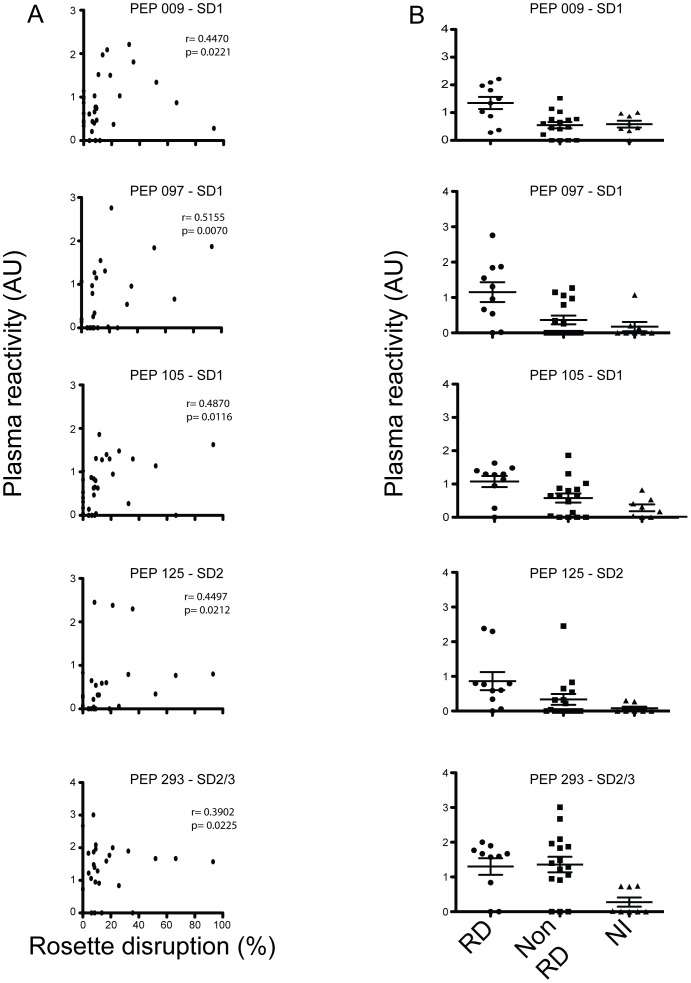
Peptides associated with the ability to disrupt rosettes of the FCR3S1.2 strain.Reactivity towards five peptides (indicated by green arrows in figure 4) was correlated with plasma sample ability to disrupt FCR3S1.2 rosettes. A) Scatter plots showing the correlation between specific peptide recognition and the ability to disrupt rosettes of FCR3S1.2 iRBC. B) Reactivity index measured in peptide array to the same peptides according to their grouping: rosette disruptive (RD), non-rosette disruptive (Non-RD) and Swedish non-immune control samples (NI).